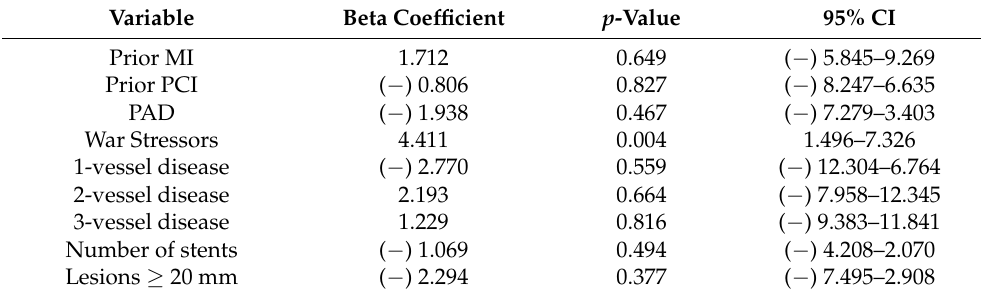
Figure 1. Frequency of war-related stress degrees within the different SX score categories.